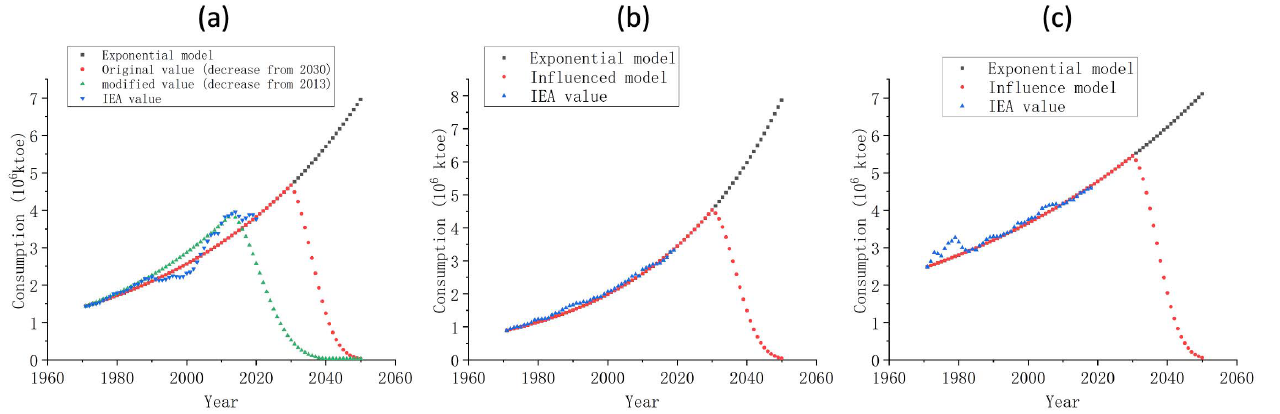
Figure 2. The consumptions of ( a ) coal, ( b ) natural gas, and ( c ) crude oil, NGL, and feedstocks, from 1971 to 2050.